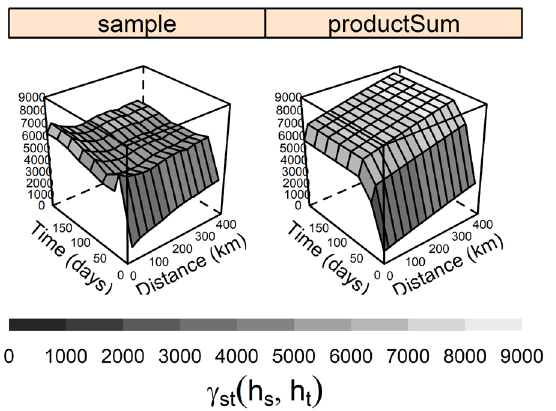
Figure 5. Empirical spatiotemporal variogram (“sample”) and the generalized product-sum adjusted variogram (“productSum”) for the precipitation residuals in the